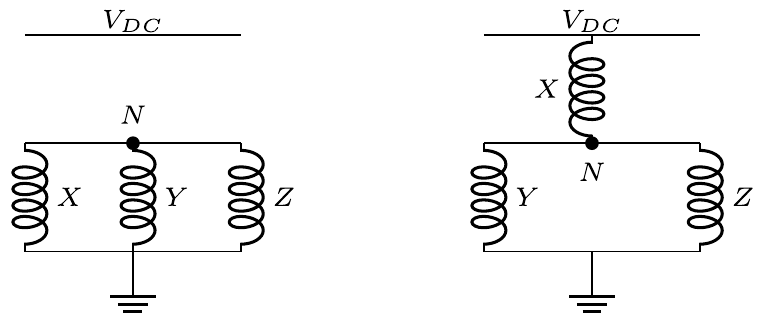
Figure 7. Machine excitation states 0 (left) and I (right), where { X , Y , Z } are the generic phases belonging to the set { A , B , C } [41].